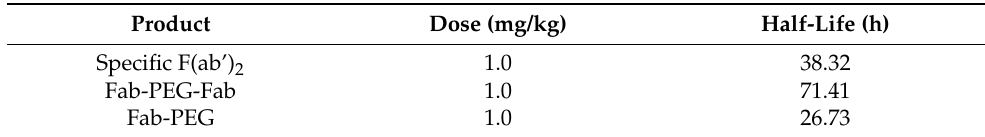
Table 3. Table of the main pharmacokinetic parameters calculated after intraperitoneal injection of specific F(ab’) 2 , Fab-PEG-Fab, and